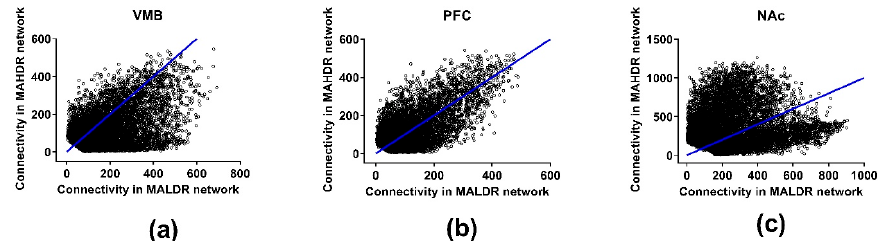
Figure 3. Effects of selection on total network connectivity for the coexpression networks in the methamphetamine high drinking (MAHDR) and methamphetamine low drinking (MALDR) selected lines. Connectivity is shown in ( a ) for the ventral midbrain (VMB), ( b ) for the prefrontal cortex (PFC) and ( c ) for the nucleus accumbens (NAc).